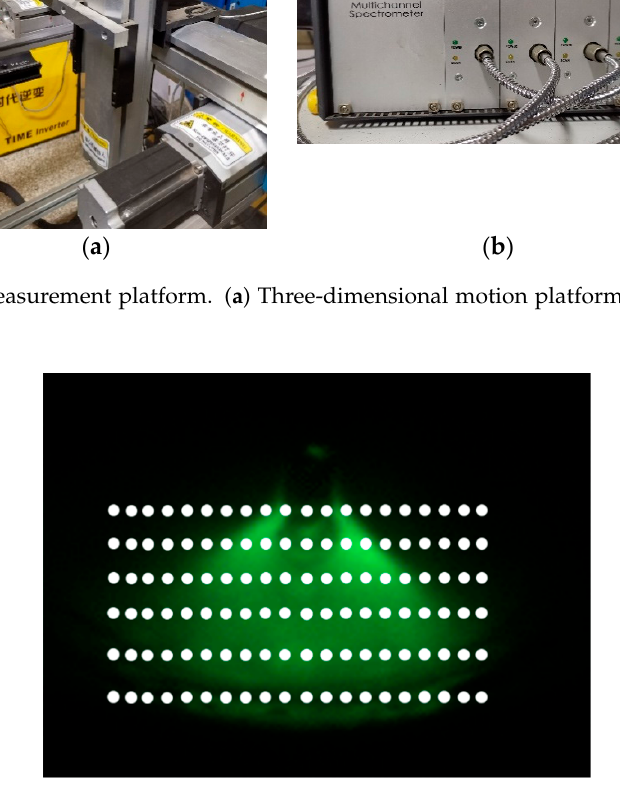
Figure 24. Distribution of collection points.